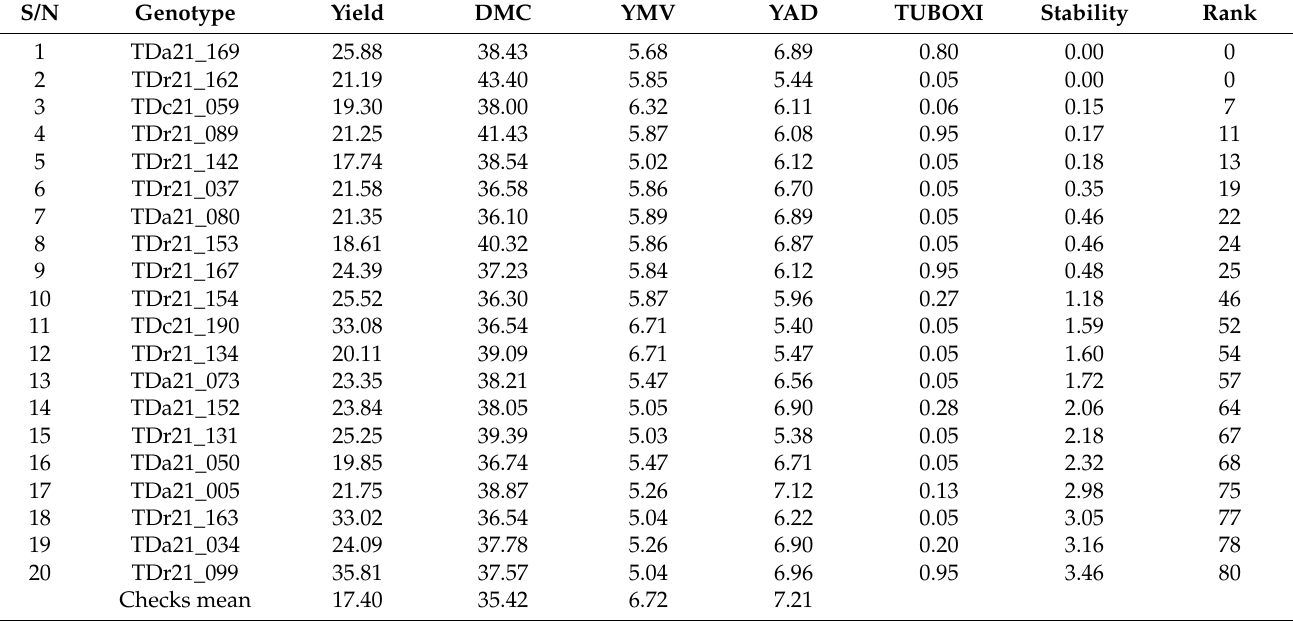
Table 8. List of the stable twenty landrace accessions with better performance over checks mean for farmers’ and consumers’ preferred